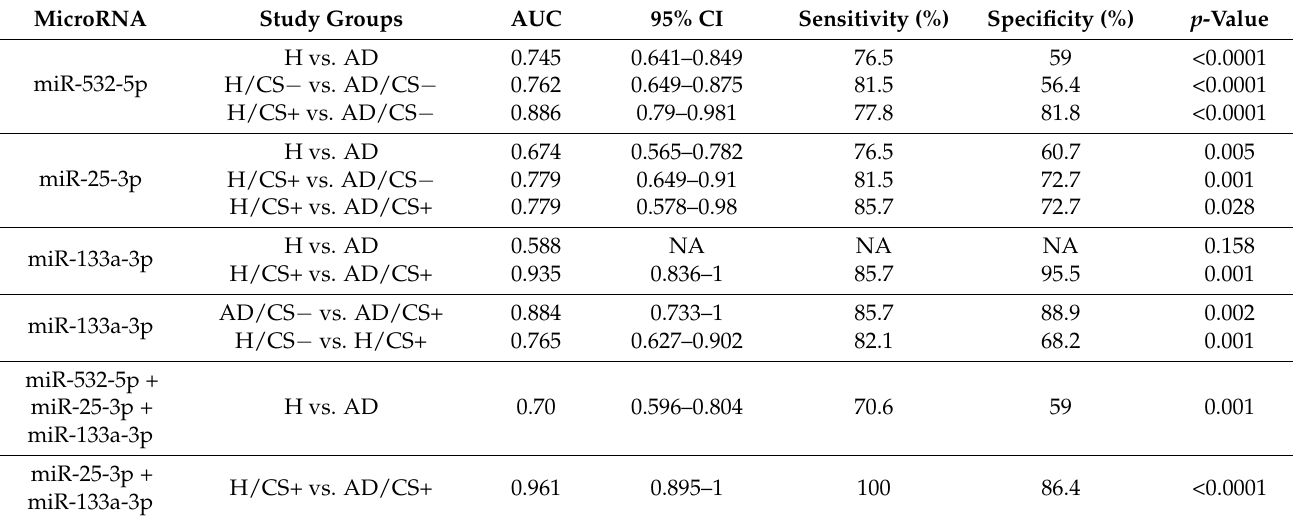
Figure 3. Receiver operator characteristic (ROC) curve analysis of ( a ) circulating miR-532-5p, ( b ) miR-25-3p and ( c ) miR- 133a-3p according to the cigarette-smoking (CS) status of adenocarcinoma (AD) patients and healthy (H) participants. Table 2. Diagnostic accuracy values of miR-532-5p, miR-25-3p and miR-133a-3p as biomarkers for AD diagnosis according to the cigarette-smoking status.